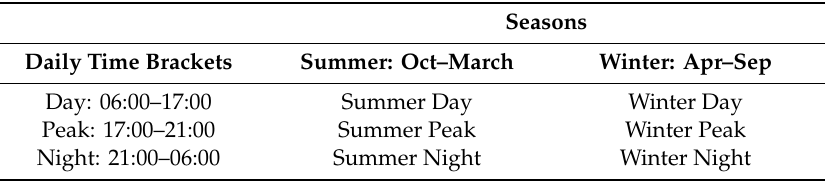
Table 4. Time slices used in the